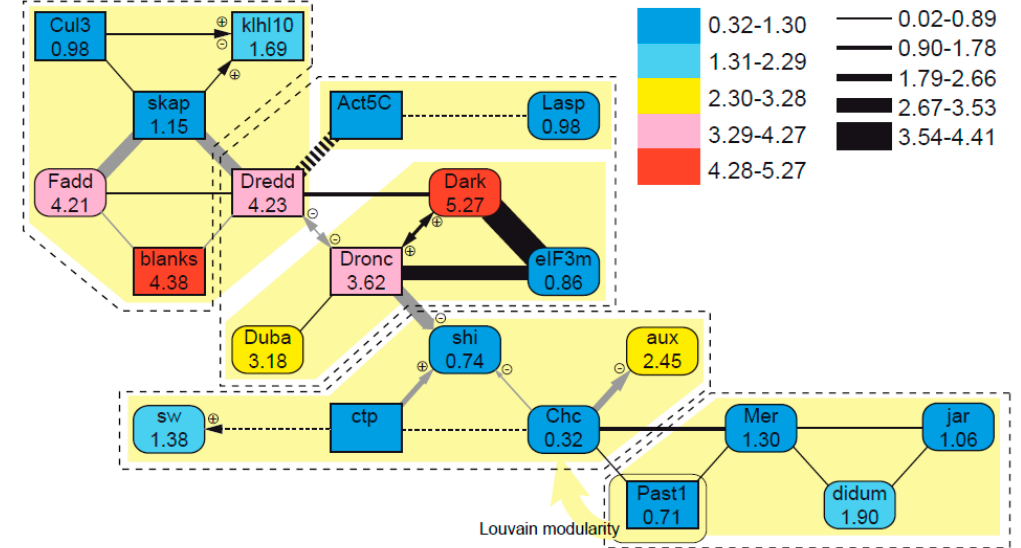
Figure 7. Mutual interaction network of sperm individualization genes in Drosophila including protein–protein (lines) and genetic/regulatory interactions (arrows), the latter with information on the enhancing and/or repressing modulation effects. Nodes represent interacting proteins, and they are color coded according to their inferred amino acid evolutionary rates. Edges represent documented interactions between proteins, with their width being proportional to the evolutionary rate differences between interacting proteins (dashed lines are used when their evolutionary rate data are missing). Dashed-line and solid-background polygons show the edge-based and node-based partitions of the network, respectively. More details and alternative partitioning schemes are described in the main text.